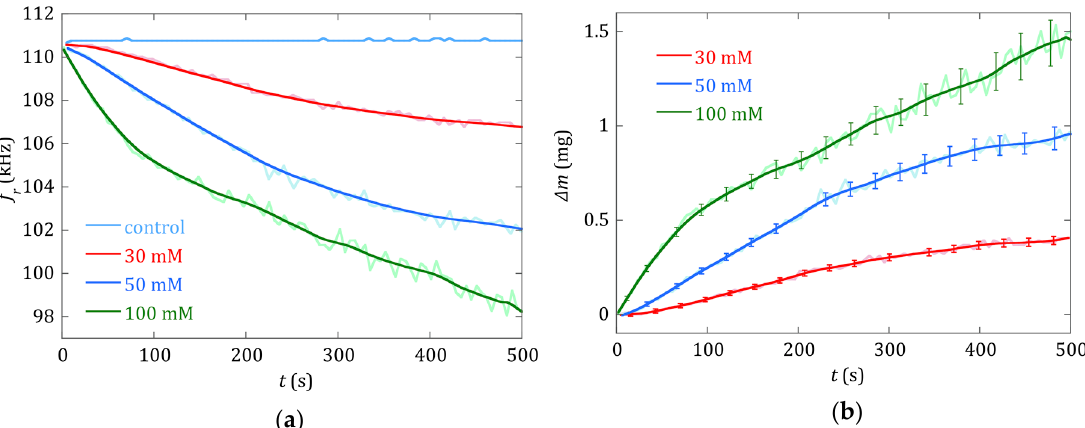
Figure 5. ( a ) Change of the magnetoelastic resonance frequency measured during the precipitation process for different reactant concentrations (30, 50 and 100 mM) and for the control test curve (sensor in a vial with distilled water). ( b ) Deposited mass of calcium oxalate crystals on the sensor during the reaction of precipitation for different reactant concentrations (30 mM, 50 mM and 100 mM), with the mass determination error. The actual measurements are plotted in light color. Intense solid curves correspond to smoothed data.